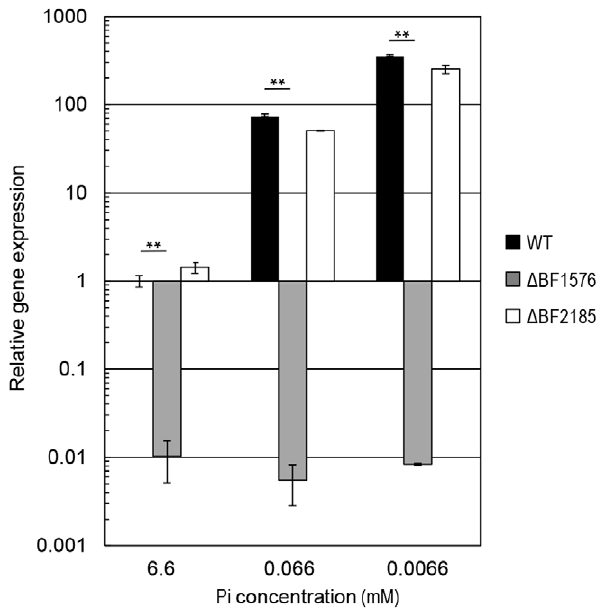
Figure 4. Induction of pstC expression in response to Pi limitation. Wild type, D BF1576, and D BF2185 strains of B. fragilis were cultured in DMM supplemented with varying concentrations of Pi as indicated. Total RNA was extracted from mid-logarithmic phase cultures, and pstC expression levels were compared by qPCR. The transcriptional level of pstC was normalized with that of rpoD and shown relative to that of a wild type strain in DMM supplemented with 6.6 mM KH 2 PO 4 (Pi-rich media). Black column: wild type; gray column: D BF1576; white column: D BF2185. **Significantly different from the wild type strain ( p ,